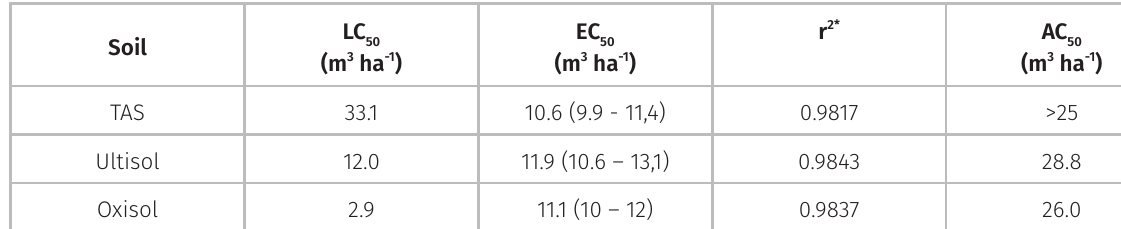
Table III. Calculated values of LC Artificial Soil (TAS), Ultisol and Oxisol with swine manure.